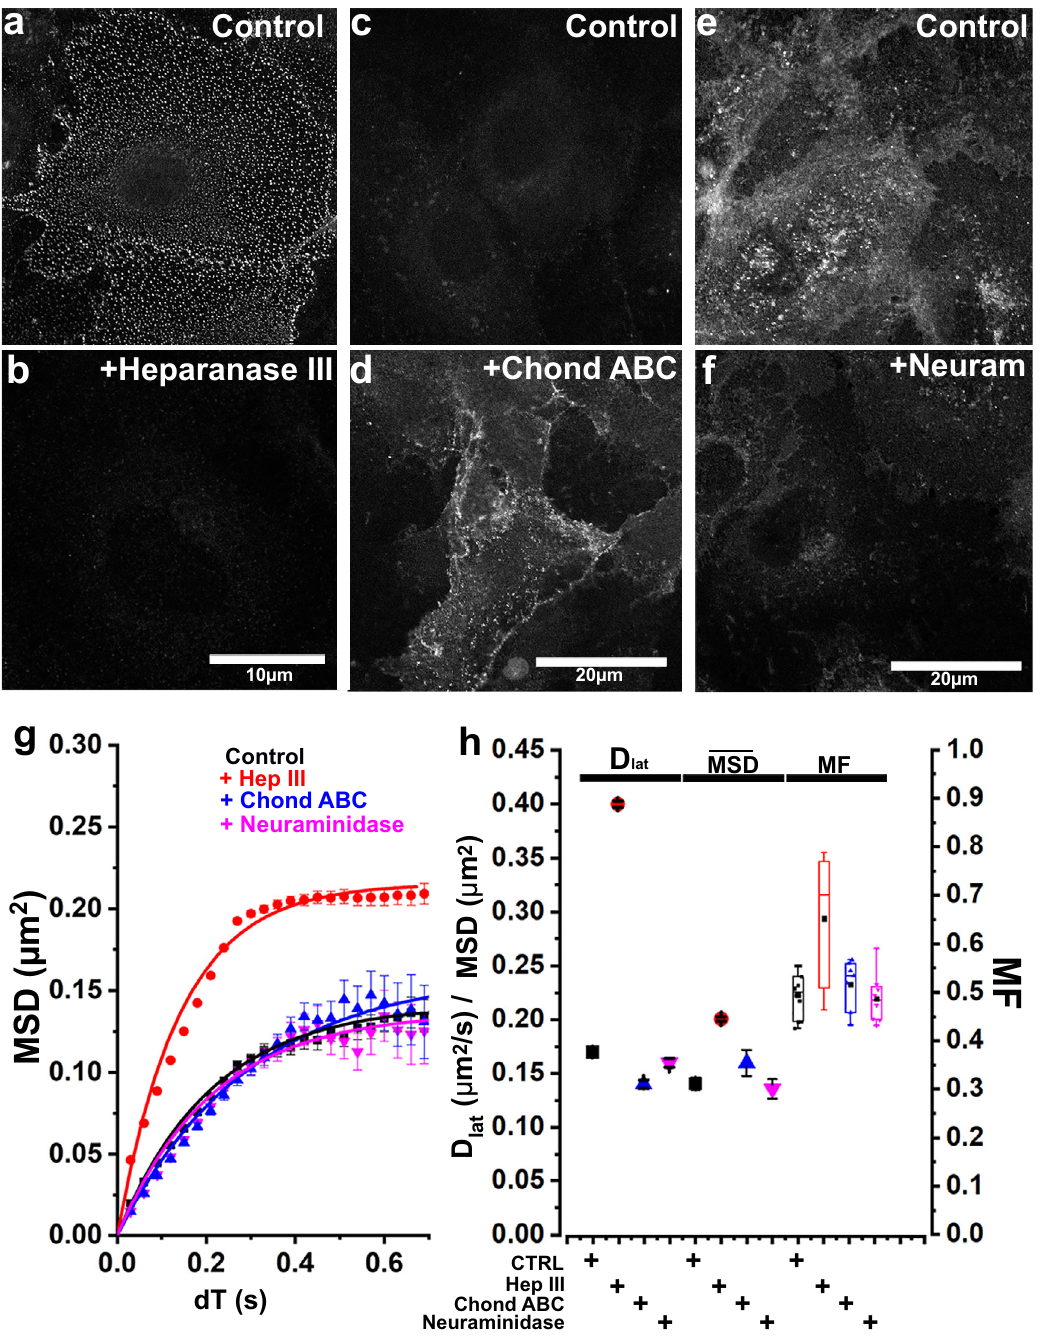
Fig. 6 Plasma membrane heparan sulfate slows P-selectin mobility. a Confocal images of fi xed HUVEC immuno-labeled with heparan sulfate-speci fi c antibody. b After treatment with heparanase III. c Confocal images of fi xed HUVEC immuno-labeled with an anti-chondroitin 4 sulfate-speci fi c antibody. d After treatment with chondroitinase ABC. Note that the antibody used here recognizes the digested chondroitin sulfate. e Confocal images of fi xed HUVEC labeled with FITC-wheat germ agglutinin. f After treatment with neuraminidase. The images shown are representative of three independent experiments for each treatment. g MSD vs dT plots for full-length P-selectin mobility measured in live cells before (black squares, 5918 SM, n = 10 cells) and after heparanase III treatment (red circles, 20,098 SM, n = 21 cells), chondroitinase ABC (blue triangles, 1482 objects, n = 7 cells), and neuraminidase (magenta triangles, 1044 objects, n = 8 cells). Solid lines are fi ts to the Kelvin – Voigt model. h Changes in mean D lat and limiting MSD ( MSD ) derived by least-squares fi tting to the Kelvin – Voigt model (solid lines shown in panel g ) error bars show 95% con fi dence intervals. Mobile fraction (MF) shown as Box and Whiskers as described in Fig. 1. One-way ANOVA multiple comparisons, Dunnett tests indicated chondroitinase ABC and neuraminidase treatments had no signi fi cant effect whereas Heparanase III treatment gave P = <0.0004 compared to